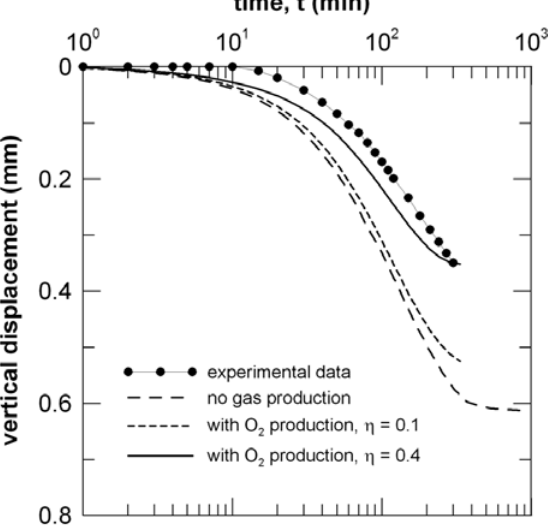
Fig. 17 – Electrokinetic consolidation test: vertical displacement at the top surface of the specimen vs.